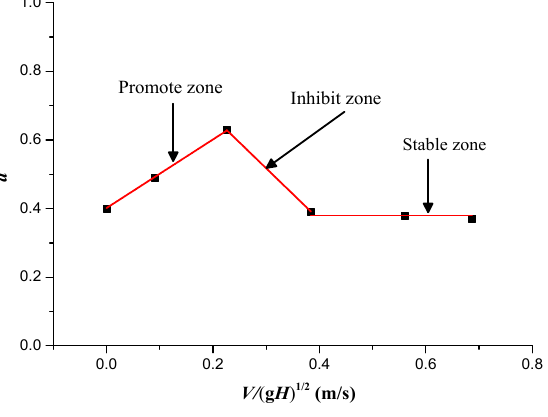
(cid:112) g H for the corridor open to the